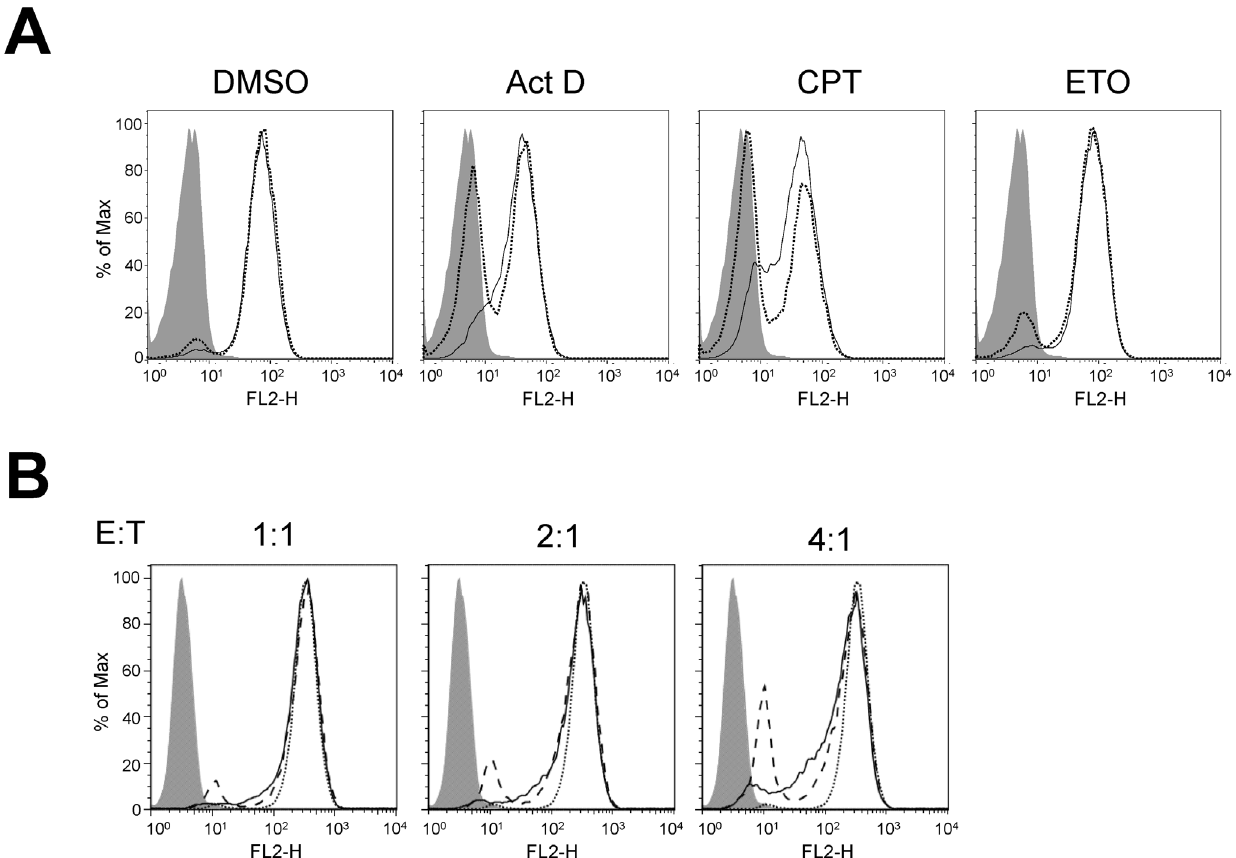
Figure 3. Inhibition of ULBP2 loss by apoptotic inhibitor. (A) Z-VAD-FMK inhibited apoptotic compound-induced loss of cell surface ULBP2 in Jurkat cells. Jurkat cells were pretreated with 50 m M Z-FA-FMK (dotted lines) or Z-VAD-FMK (solid lines) for 30 min, and then were treated with 2 m g/ ml ActD, 4 m M CPT or 20 m M ETO for 4 hours at 37 u C. Cell surface expression of ULBP2 was determined by flow cytometric analysis using PE- conjugated mouse anti-human ULBP2. PE-conjugated mouse IgG2a was used as an isotype control (gray-shaded). (B) Z-VAD-FMK inhibited NK cell- mediated loss of cell surface ULBP2 in H9 cells. 1.5 6 10 5 H9 cells were incubated with IL-2 expanded human primary NK cells at the indicated E:T ratios for 2 hours, and the cell surface expression of ULBP2 was determined by flow cytometric analysis using PE-conjugated mouse anti-human ULBP2 antibody. NK cells were gated out by FSC/SSC and APC-conjugated CD56 antibody. ULBP2 expression in control H9 cells in the absence of NK cells are shown in dotted lines, whereas ULBP2 expression in H9 cells incubated with NK cells are shown in dashed lines (DMSO) and solid lines (Z-VAD-FMK), respectively.